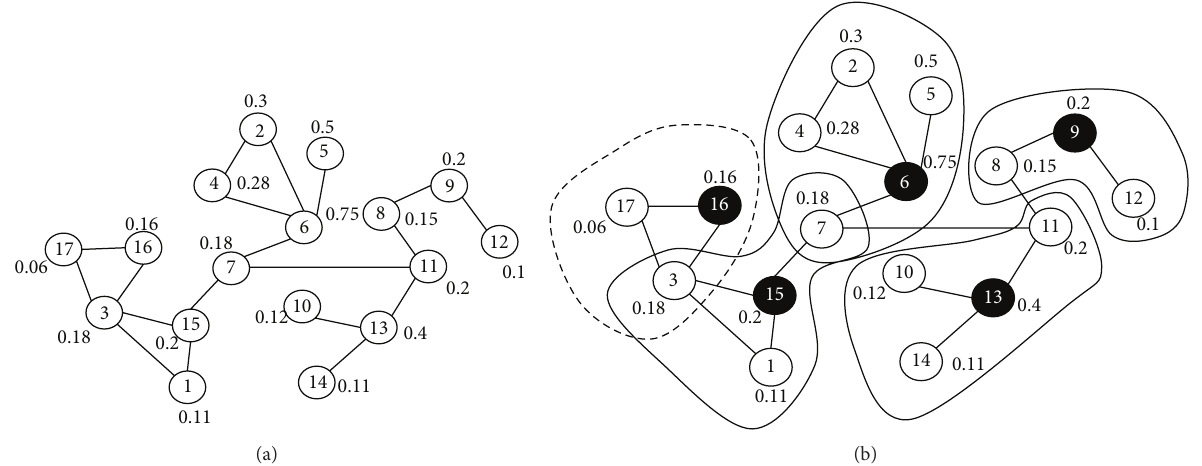
Figure 3: A MANET (a) before clustering and (b) after clustering with VLWBC algorithm.